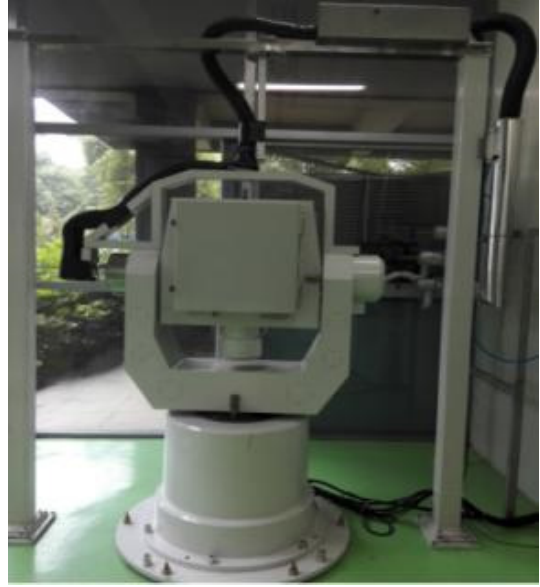
Figure 1. Three-axis turntable.